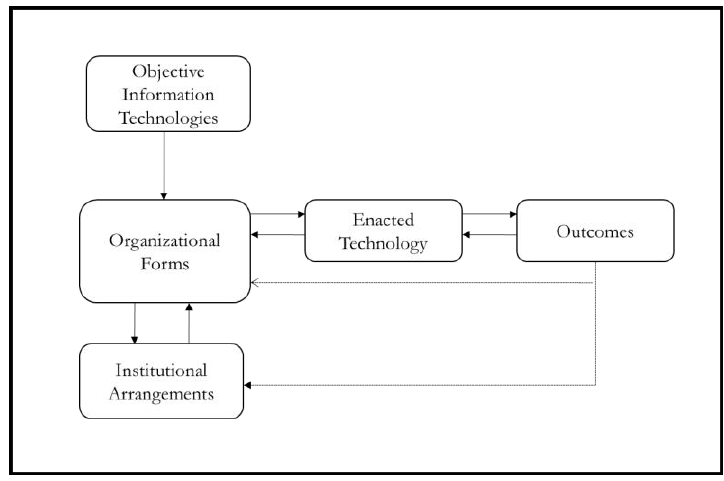
Figure 1: Technology enactment framework (Fountain,